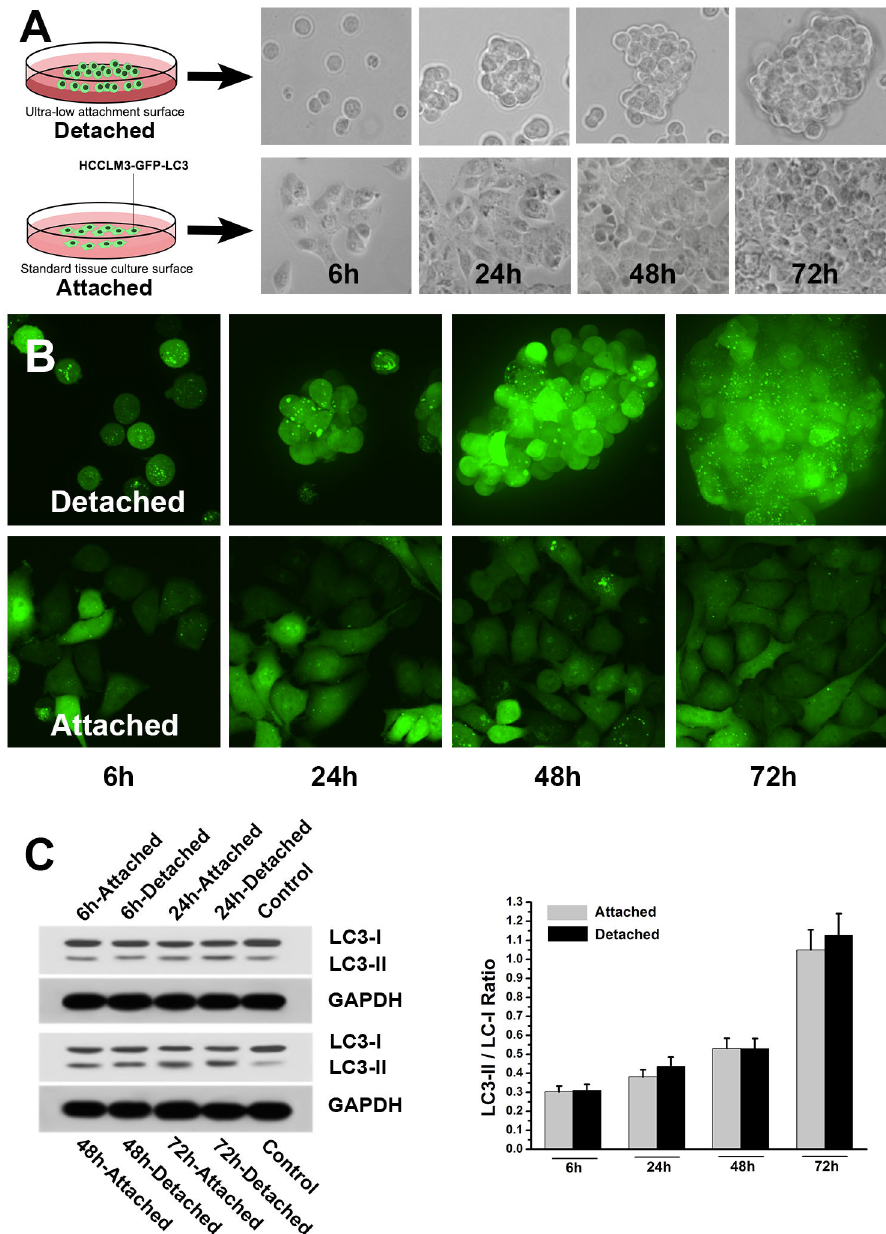
Figure 6. Dynamic monitoring of autophagy showed no significant autophagic alteration after cell detachment. (A) In vitro cell detachment model was established by culturing stable GFP-LC3-expressing HCC cells (HCCLM3-GFP-LC3) on dish with ultra- low attachment surface. The suspended cells maintaining in unattached state in dish with ultra-low attachment surface were detached cells, while the adhesive cells grown in dish with standard tissue culture surface were attached cells. (B) Confocal microscopic monitoring of autophagic alterations after cell detachment. (C, D) Western blot analysis showed that the LC3-II/LC3-I ratios of detached cells were not significantly different from those of attached cells at various time points (6h, 24h, 48h and 72h after cell detachment) (all P